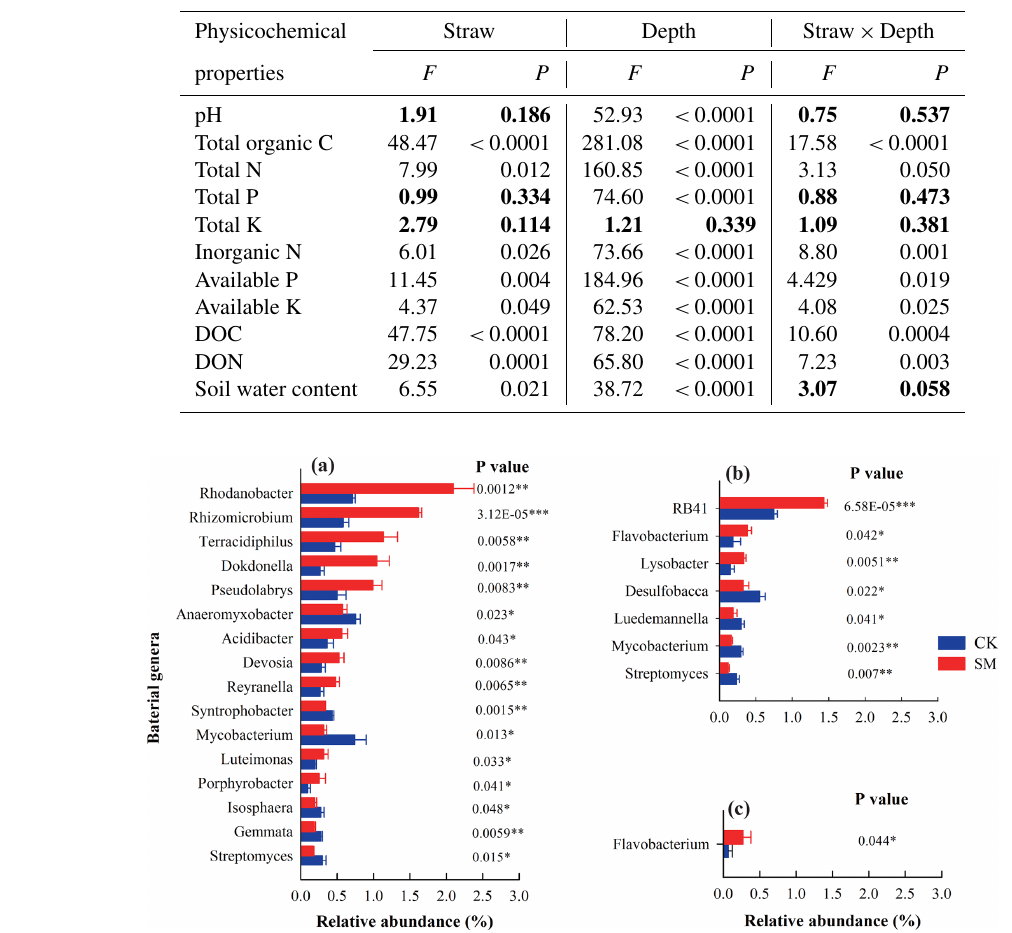
Figure 1. Bacterial genera that had significantly different relative abundances under CK and SM treatments at 0–5cm (a) , 10–20cm (b) , and 20–30cm (c) determined using t -tests with 95% confidence intervals. CK, no-till with straw removal; SM, no-till with straw